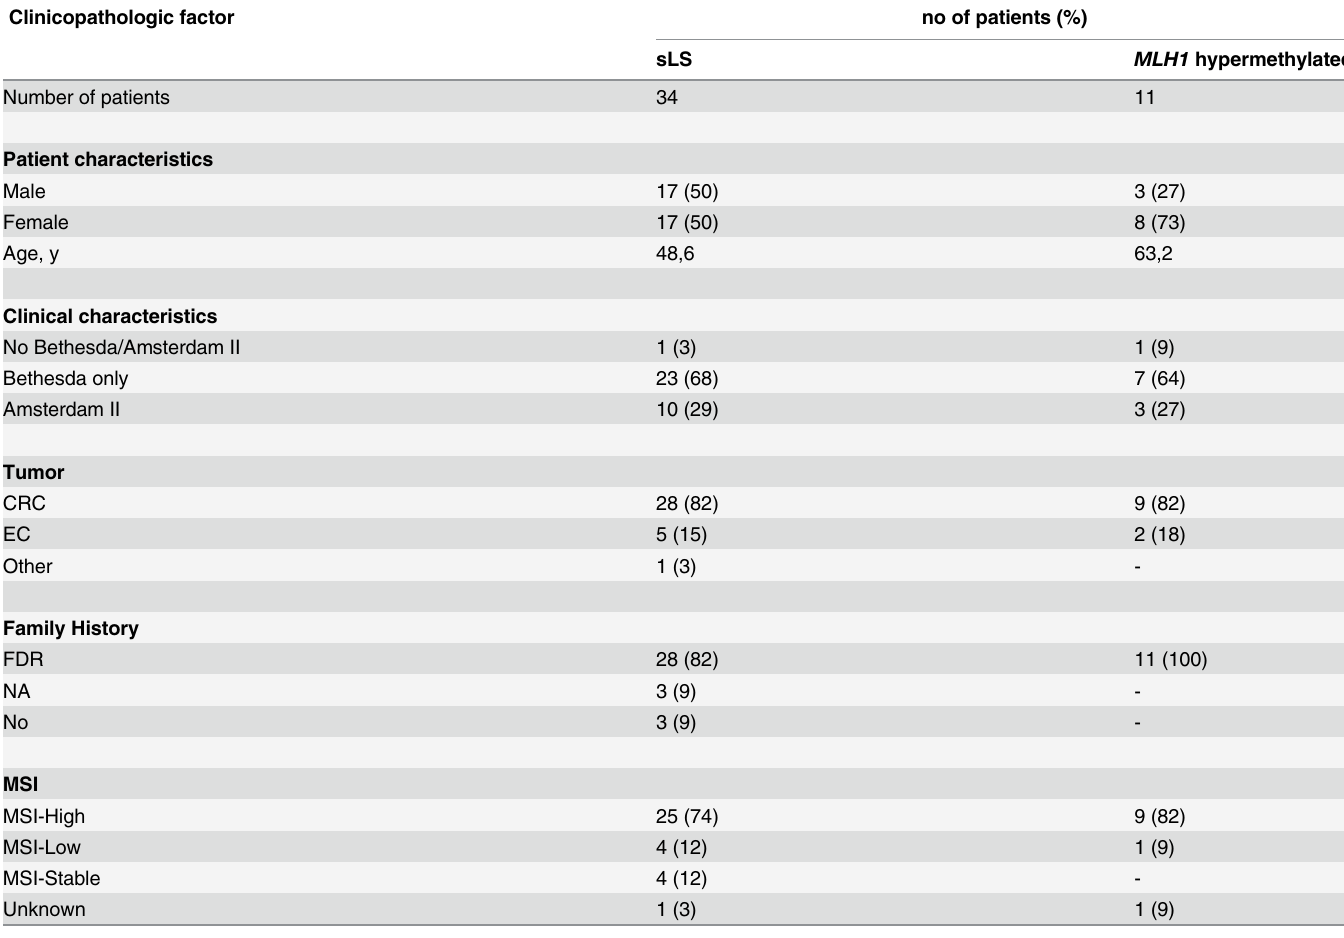
Clinicopathologic factors of the 34 sLS- and 11 MLH1 hypermethylated patients. Patients presented with colorectal cancer (CRC), endometrial cancer (EC) or other LS-associated tumors (Other). Family history is de fi ned as fi rst degree relative with a LSAT (FDR), no family history of LS (No) or family history not available